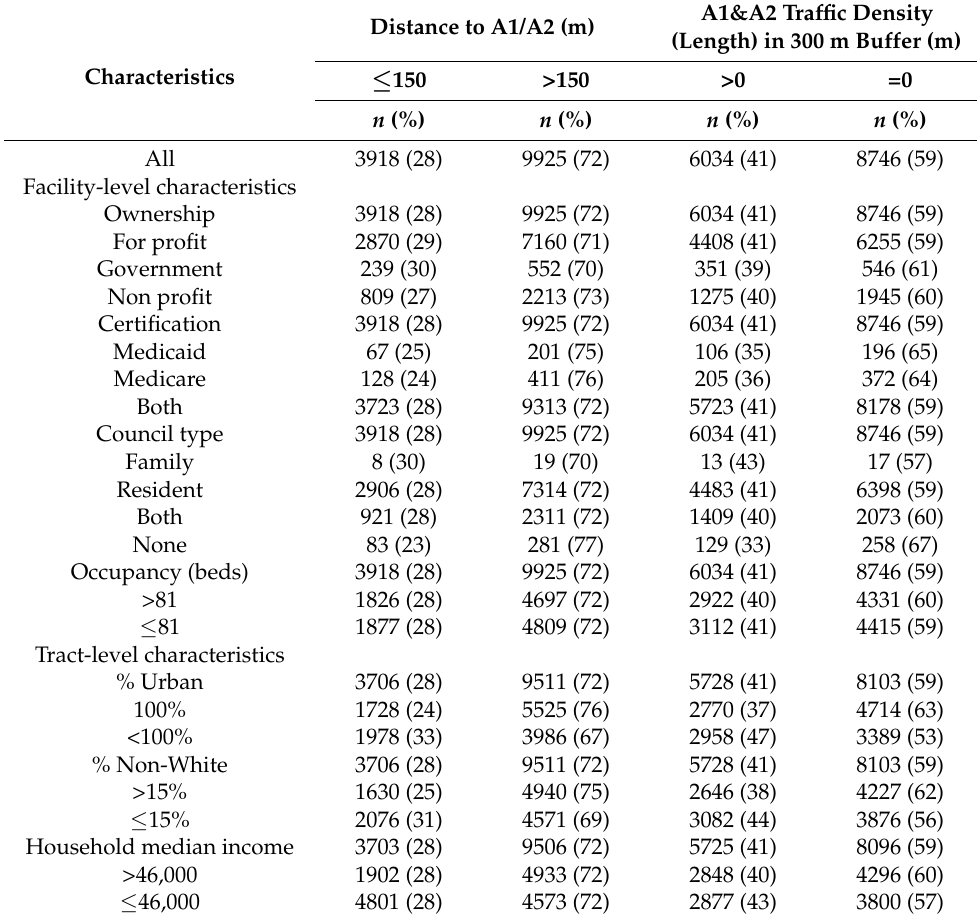
Table 1. Facility- and census-tract-level characteristics of nursing facility by distance to nearest major roadway (A1 or A2) * and by high /low traffic density (length) of major roadways (A1 and A2) within 300 m buffer a